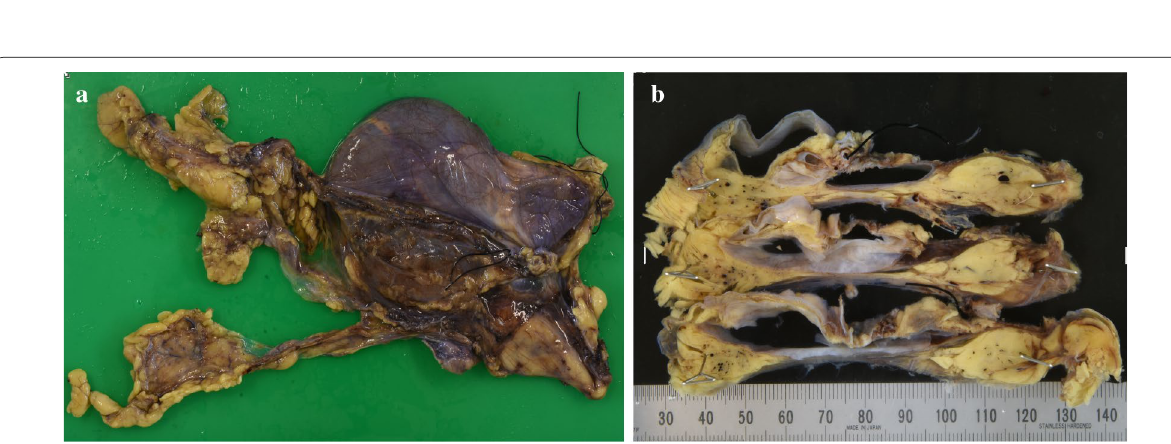
8.5 2 cm in diameter located at the upper pole of the thymus. b The cut surface of the cyst revealed × ×